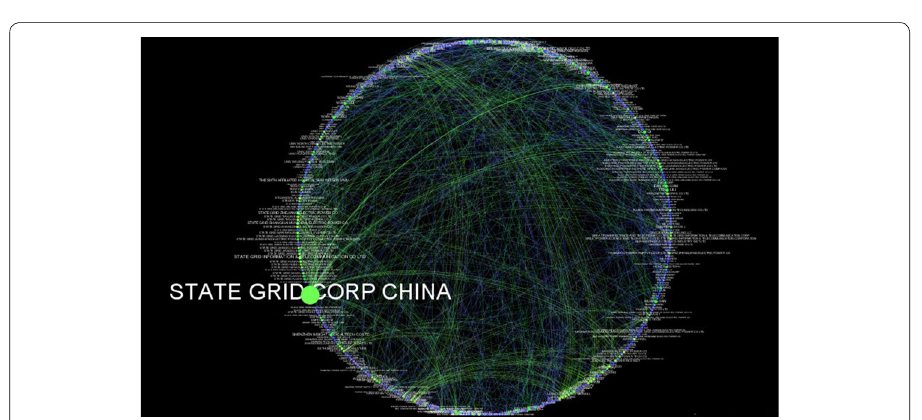
Fig. 10 Network of global